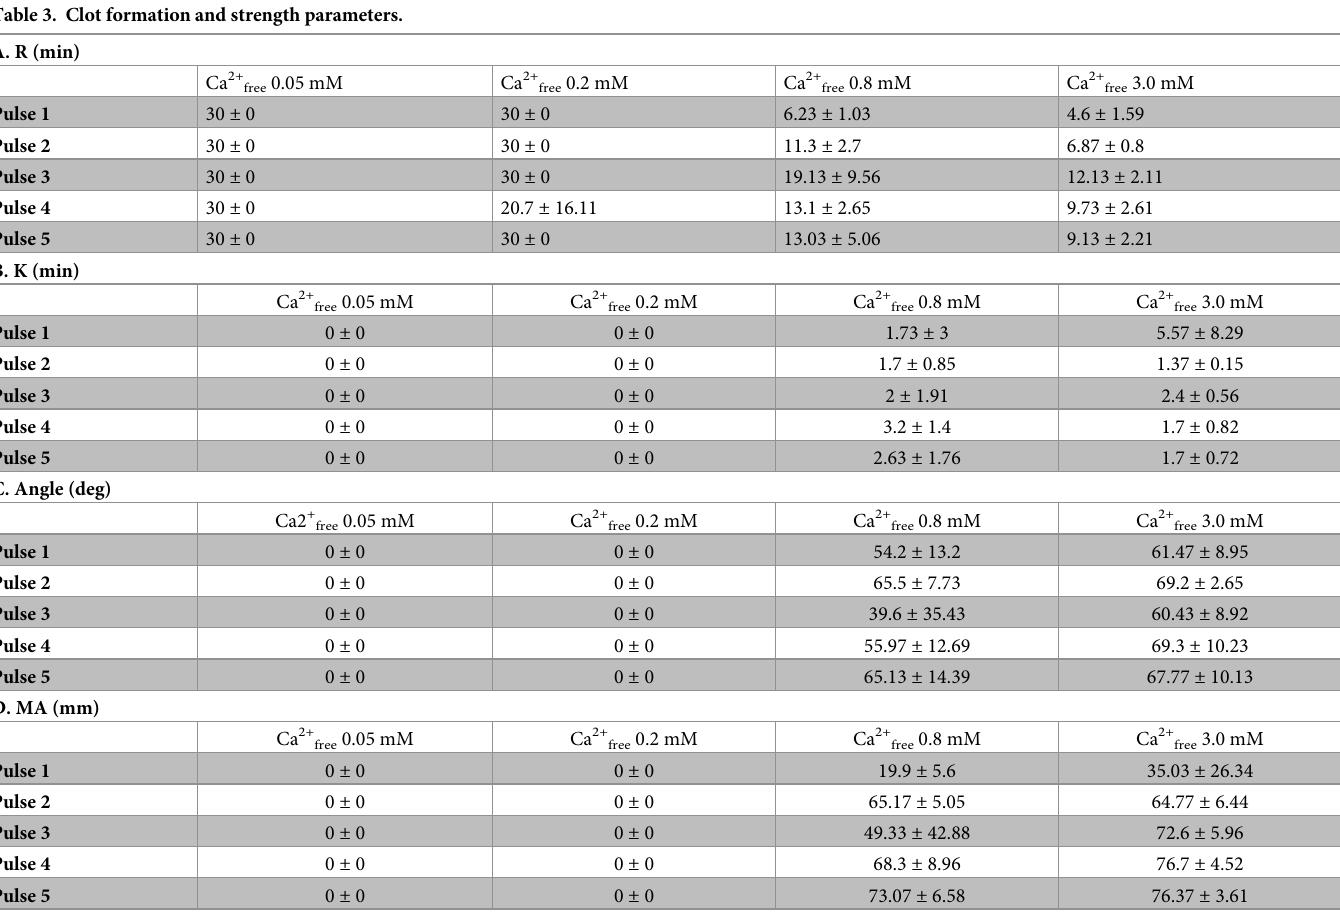
Results shown are means ± SD, n =